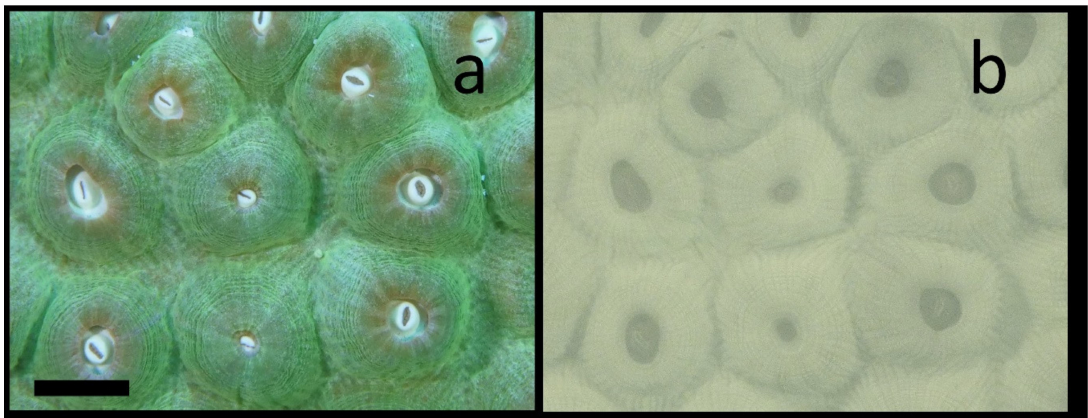
Figure 4. Daytime in situ NIR imaging of chlorophyll fluorescence from Montastraea cavernosa with external white LED illumination. ( a ) Visible image shows that most polyps are completely retracted in this green color morph. ( b ) NIR fluorescence image still shows clear asymmetric striations in each polyp. The scale bar in the visible image is about 10